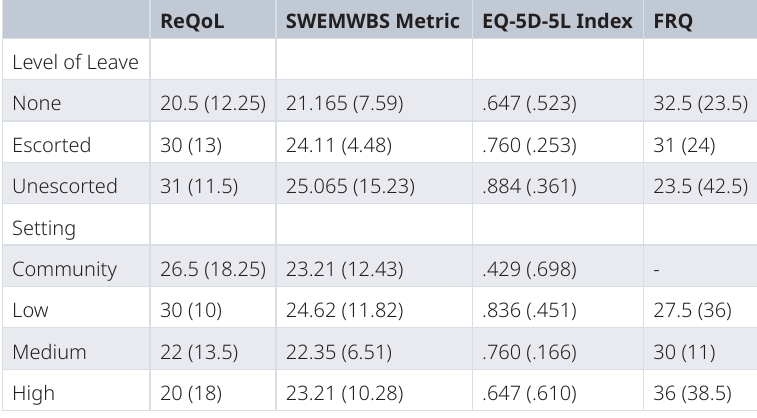
Table 6. Mental health and wellbeing across treatment settings and levels of